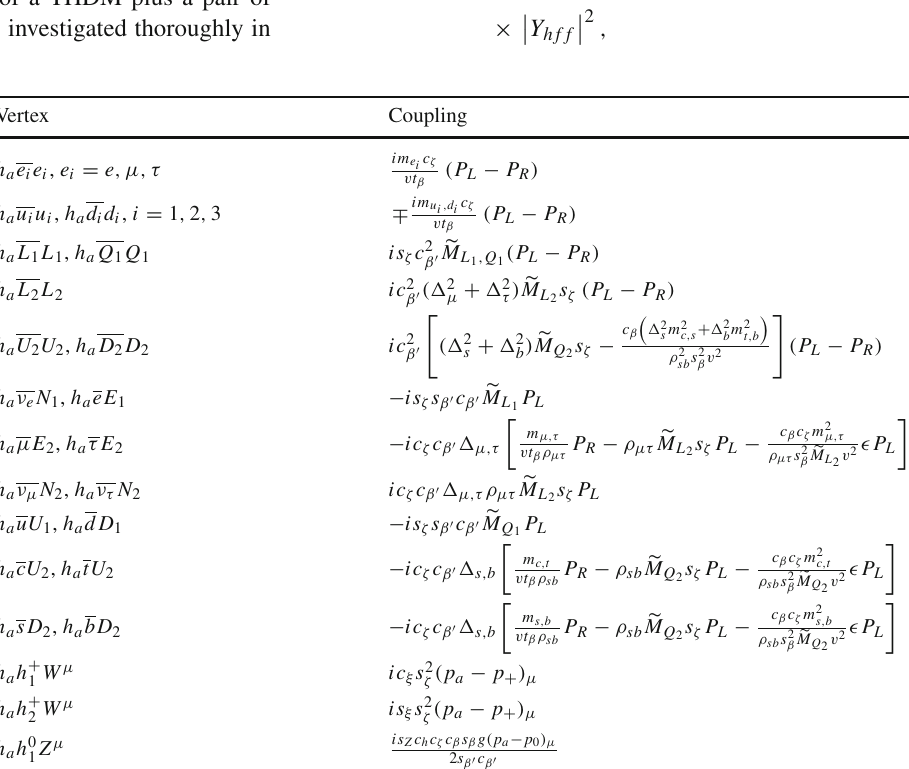
Table 6 Possible large couplings of h 0 Higgs bosons Vertex Coupling